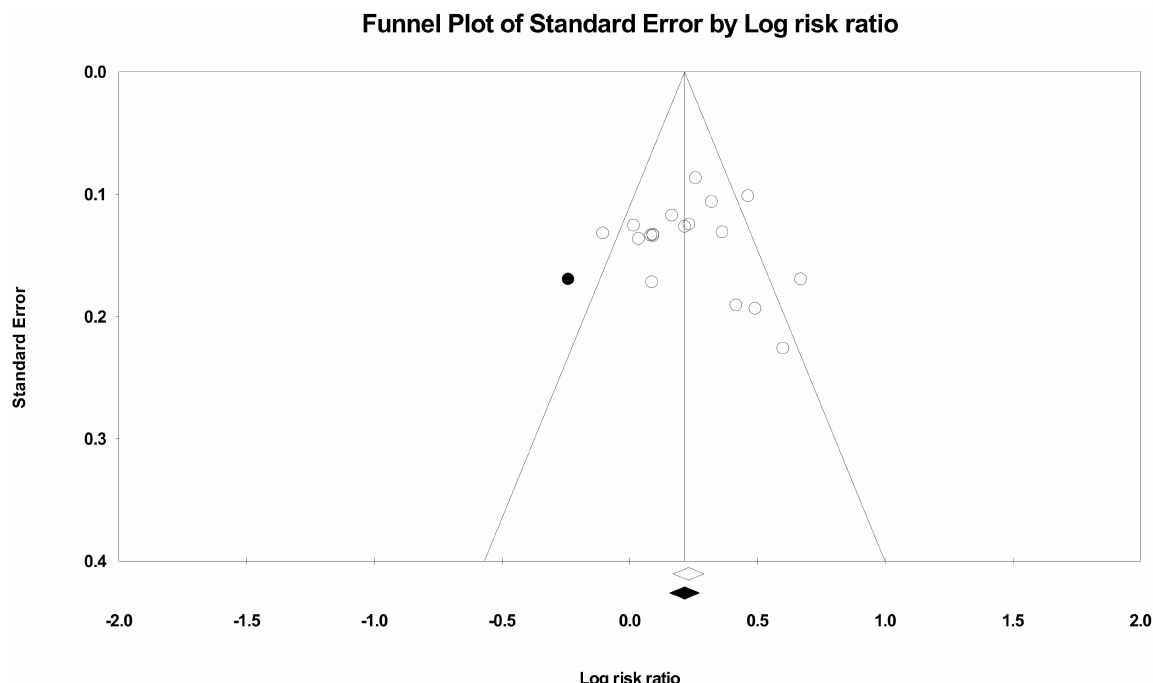
Figure 4. Funnel plot of rate of target blood pressure by log risk ratio (plot observed and imputed), random effects model. Figure 2. Funnel plot of systolic blood pressure by Hedges’ g (plot observed and imputed), random effects model . Notes. Summary effect size (